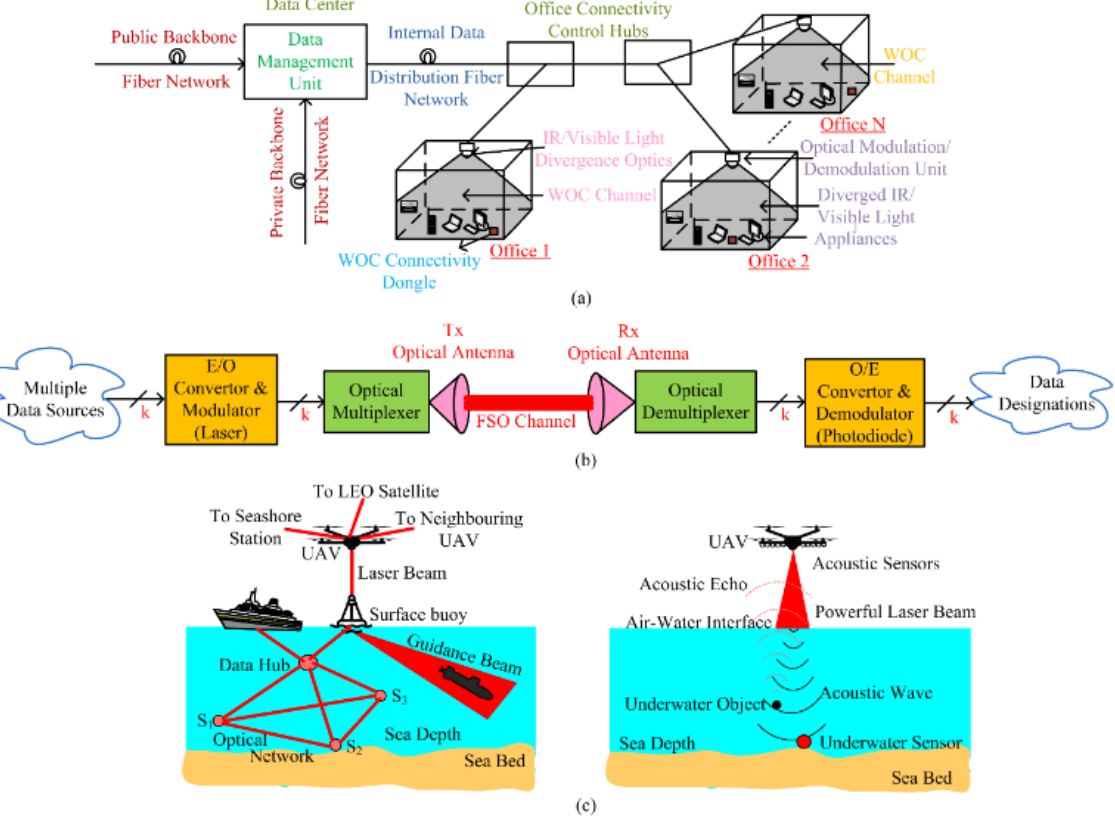
Figure 3. ( a ) The architecture of a WOC network installation; ( b ) a ‘k’ baseband channel FSO communication system; and ( c ) OWC systems.